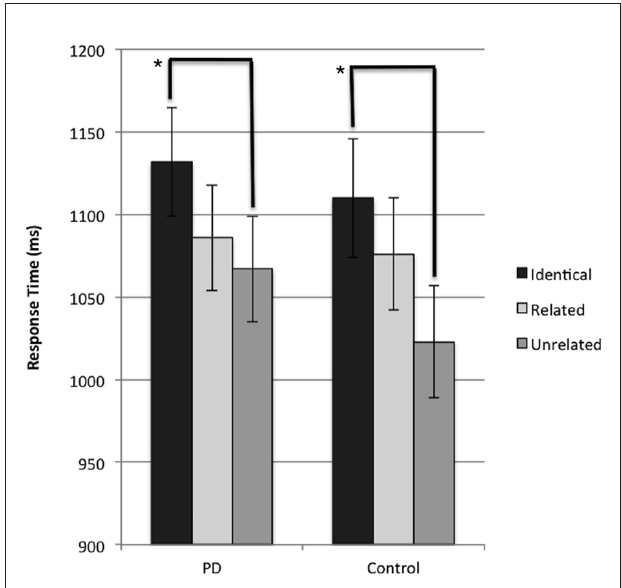
FIGURE 2 | Mean response time (ms) for probe responses in identical, related, and unrelated conditions for each group. Brackets indicate significant differences ( ∗ p < 0.05). Error bars indicate mean standard error.